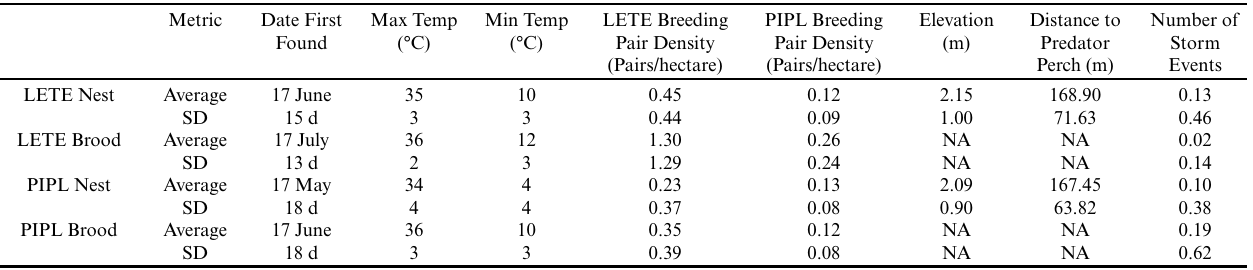
Table 1. Summary statistics for Interior Least Tern (LETE) and Piping Plover (PIPL) nest and brood explanatory variables.